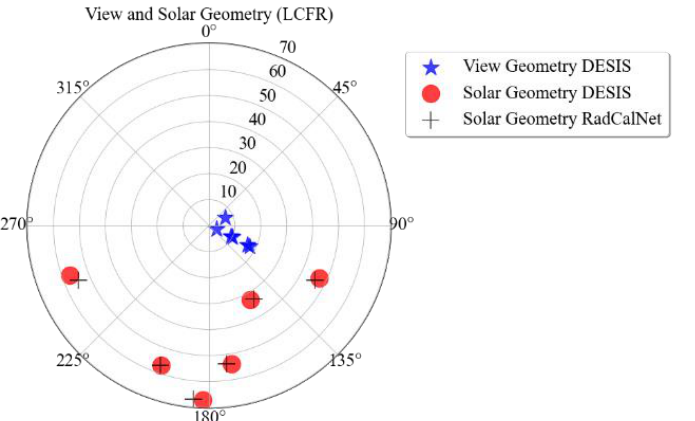
Figure 13. DESIS and RadCalNet acquisition geometry on LCFR. The blue and red symbols represent DESIS viewing and solar geometry, respectively. The black symbols represent RadCalNet solar geometry.